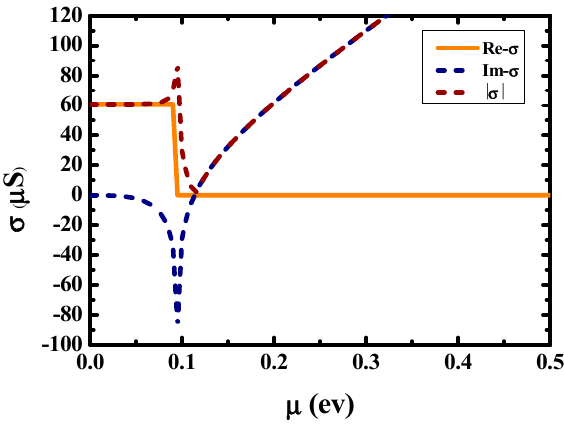
Figure 2. Dependence of conductivity on chemical potential.